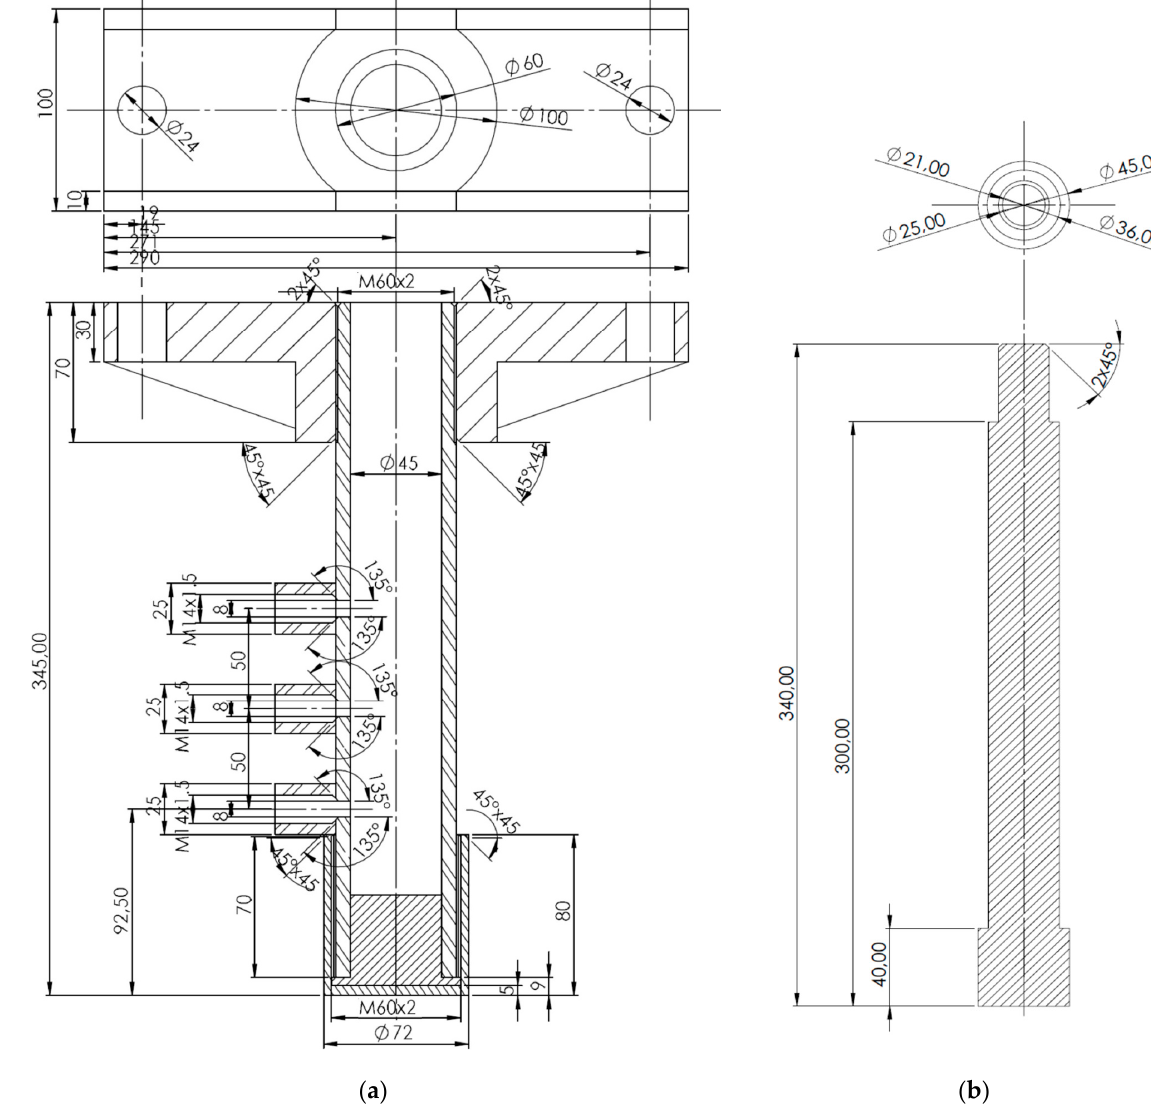
Figure 1. The technical drawing of ( a ) the compaction head and ( b ) the piston. The compaction process involves compression of force no greater than 100 kN. The force values will be changed if the quality of the produced sample cannot be satisfied. Compression was performed on samples measuring about 100 cm 3 . Constant parameters were the inner diameter of the compaction chamber (45 mm) and its length (300 mm). The parameters of the compaction head and the maximum compaction pressure reach 63 MPa. The sample strength is determined by the amount of resistance created when compressive stresses are applied in a given direction. Different materials can have different compressive strengths due to their anisotropic nature. The actual image of the compaction head and displacement simulation is presented in Figure